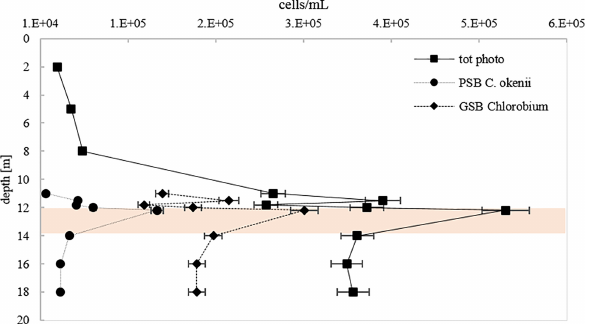
Fig 6. Flow cytometryquantification of phototrophic cells in Lake Cadagno water column. Total photosynthetic cells, PSB C . okenii ,GSB Chlorobium spp. vertical profile. Orange shadinghighlight chemocline layer (9:00 AM, 12 July 2016).